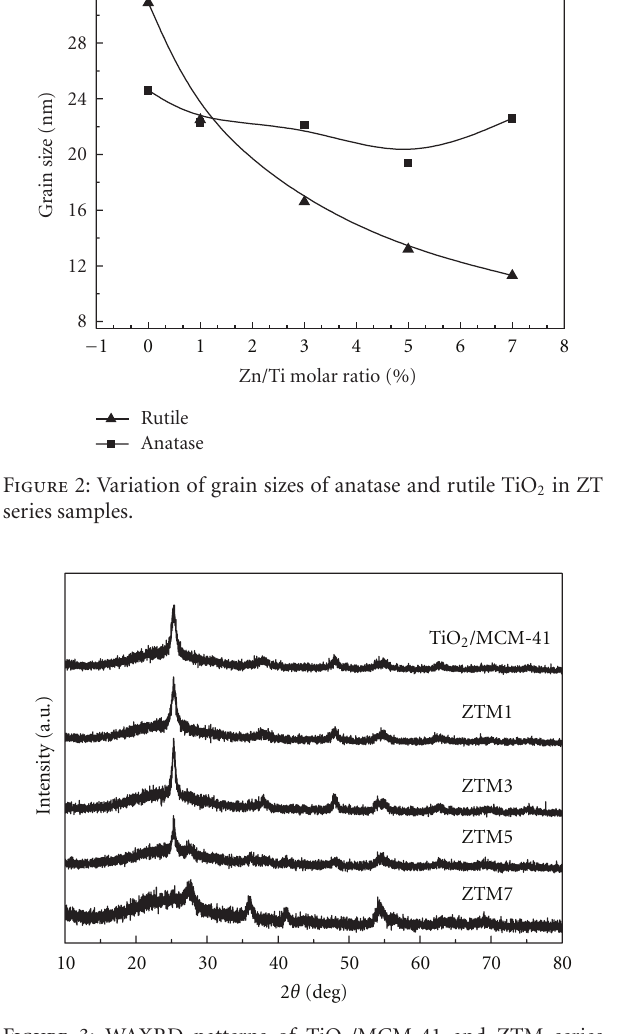
Figure 3: WAXRD patterns of TiO 2 /MCM-41 and ZTM series samples.